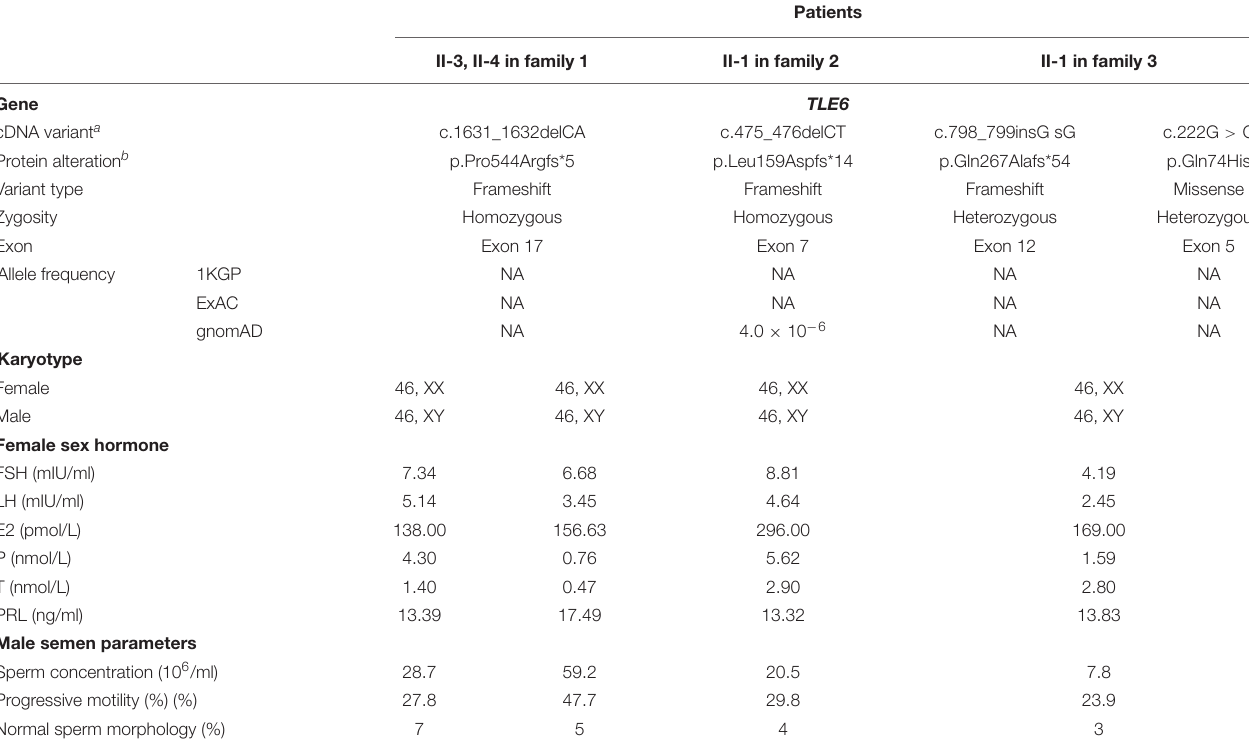
TABLE 1 | Clinical laboratory evaluation for the patients carrying variants in